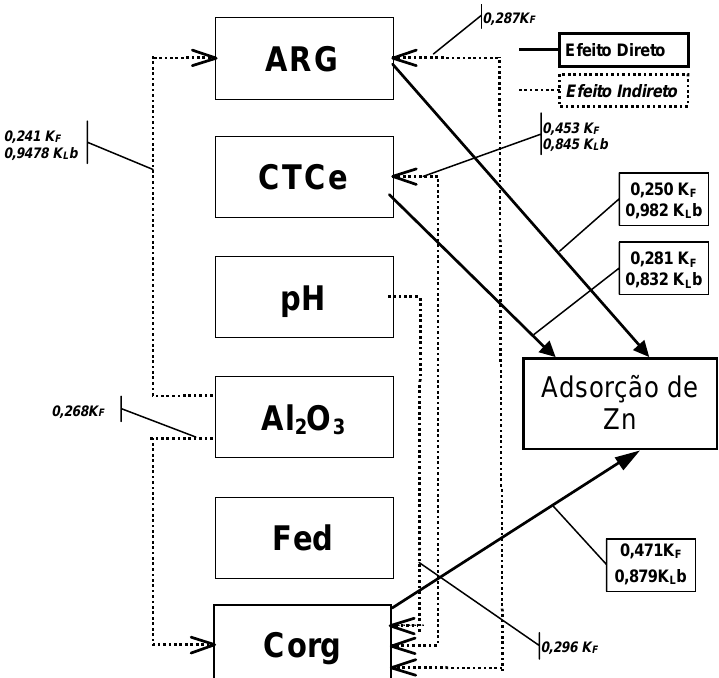
Figura 3. Diagrama explicativo com os valores dos efeitos diretos e indiretos obtidos da análise de trilha para as constantes Freundlich (K de Corg, CTCe, pH, ARG, Al